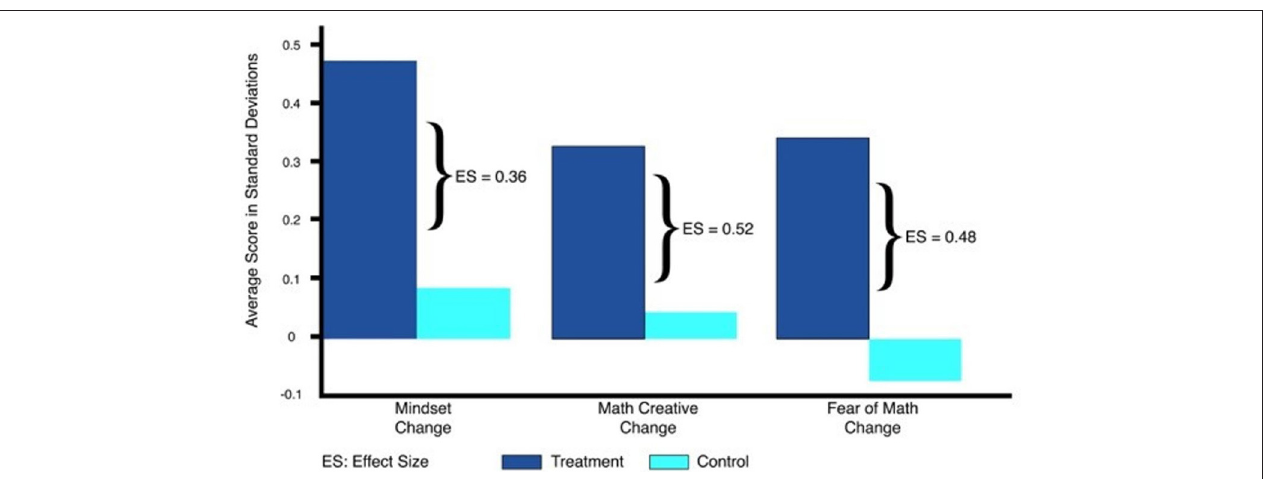
FIGURE 1 | Student mindset survey scores and effect size by